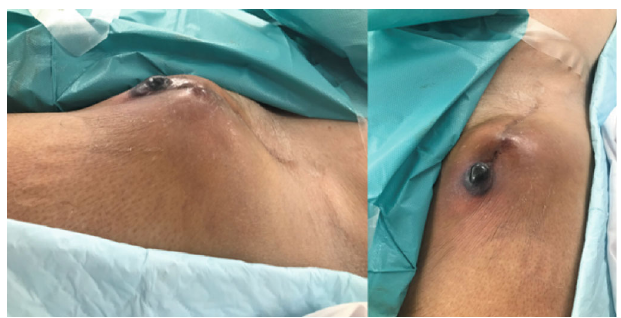
Figure 1: Infected pseudoaneurysm in the left groin.